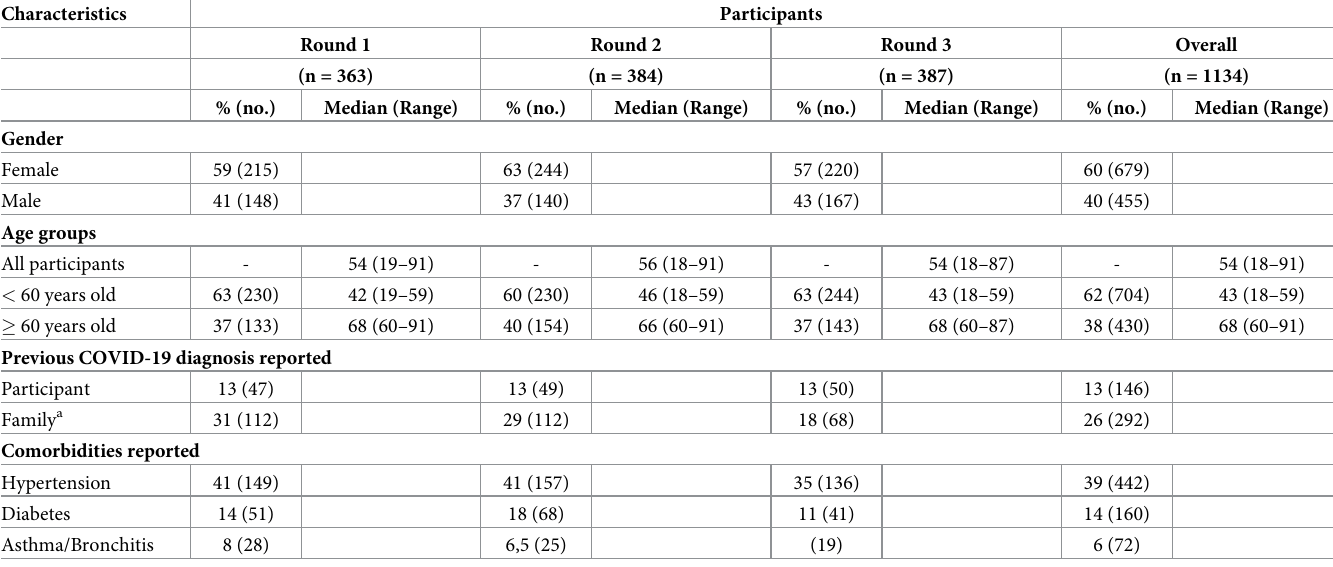
Table 1. Overview of sociodemographic and epidemiological data in all three studies.